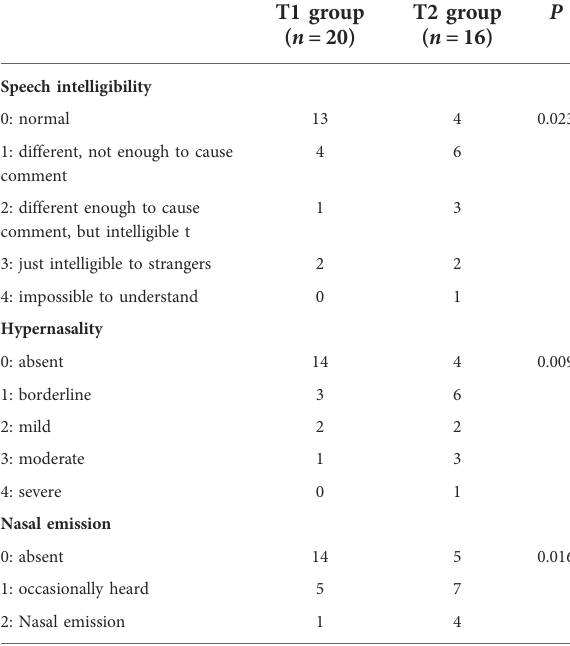
TABLE 2 Comparative analysis of speech intelligibility, hypernasality and nasal emission in furlow and sommerlad palatoplasty groups. T1 group ( n = 20)